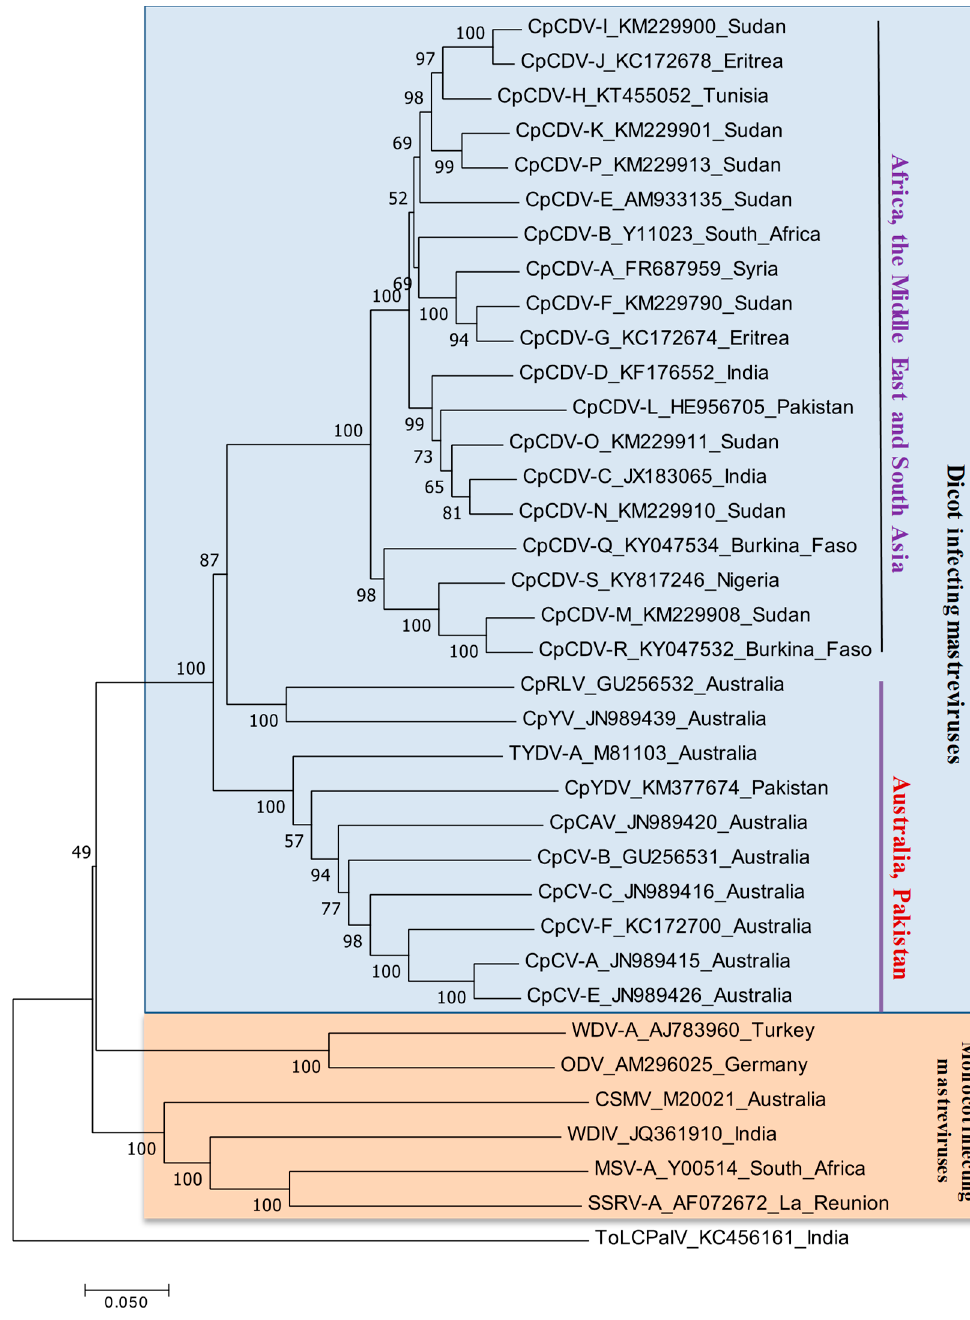
Figure 4. Phylogenetic relationships among infecting mastreviruses. Phylogenetic relationships among the full-length dicot infecting mastreviruses available in the GenBank. The neighbor-joining method was sued to construction of the tree with the MEGA 6 software program (http://www.megasoftware.net) and the reliability of the branches was inferred from a bootstrap analysis of 1000 replicates and only the nodes with values greater than 50% are labelled. DNA A sequence of the bipartite begomovirus species tomato leaf curl Palampur virus (ToLCPalV) was included as an outgroup.